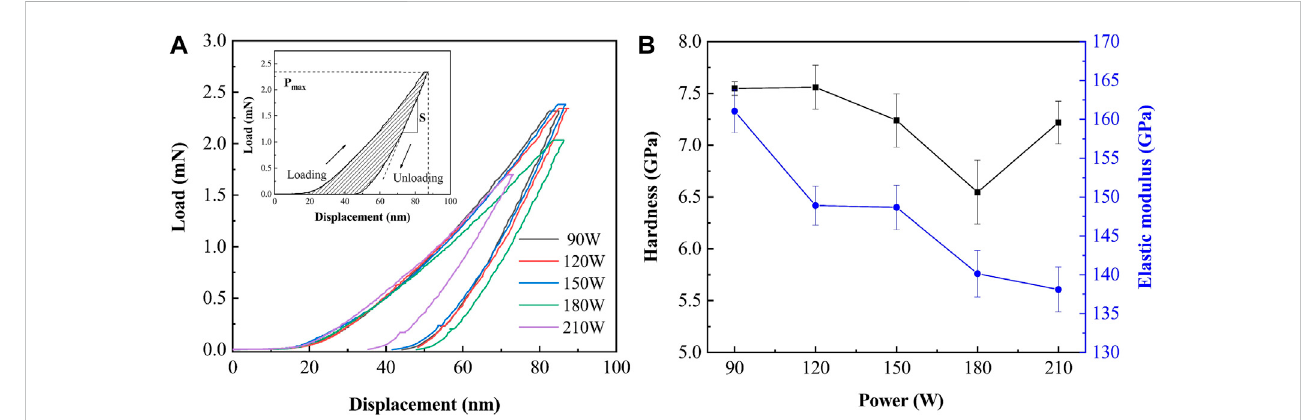
FIGURE 5 (A) Load-displacement curve with an analysis schematic diagram in the illustration and (B) hardness and elastic modulus of the ZrNbTiMo RHEA fi lms deposited at different sputtering power.